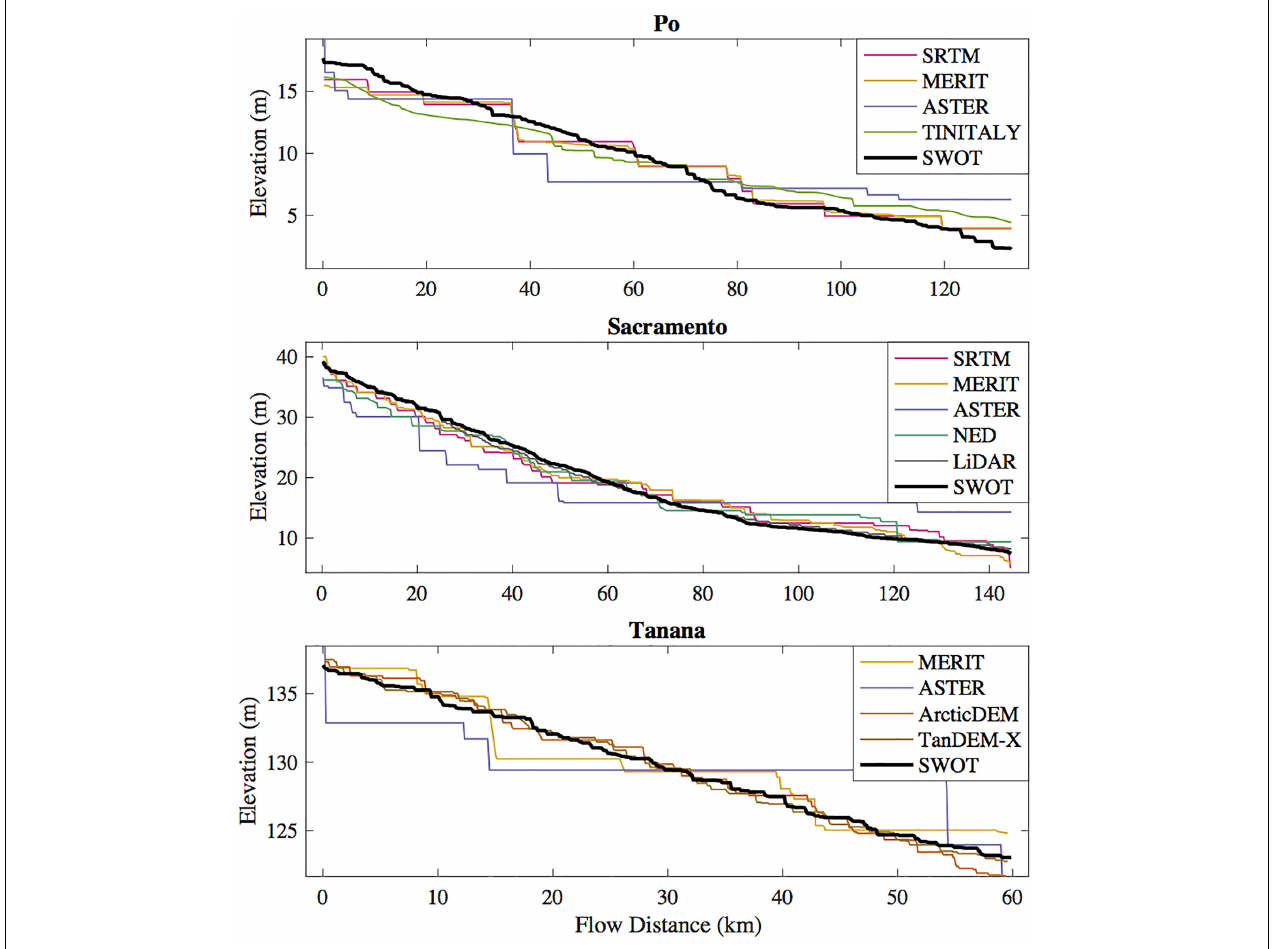
FIGURE 6 | River profiles extracted from existing publicly available DEMs and the simulated SWOT-derived river